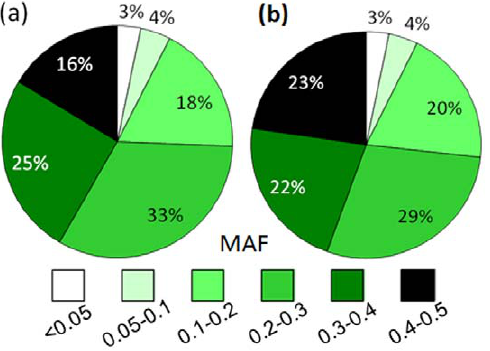
Figure 4. Distribution of minor allele frequencies (MAF) in two independent germplasm sets. A. EU evaluation panel (n=232); B. US evaluation panel (n=115; cultivars and advanced selections only).